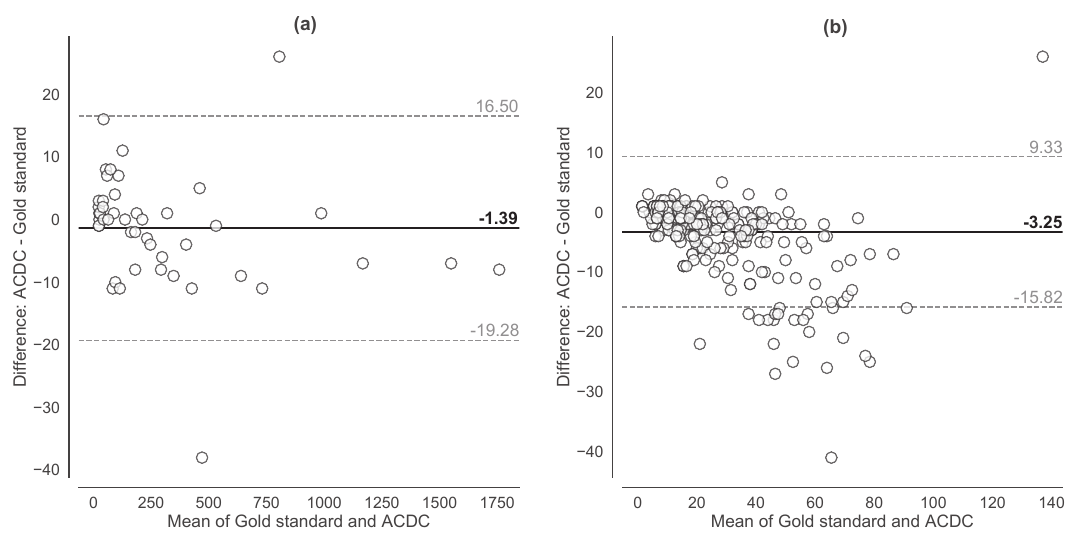
Figure 10. Bland-Altman plots of the cell counting measurements achieved by ACDC versus the gold standard for the ( a ) VU and ( b ) DSB datasets. Solid horizontal and dashed lines denote the mean and ± 1.96 standard deviation values,